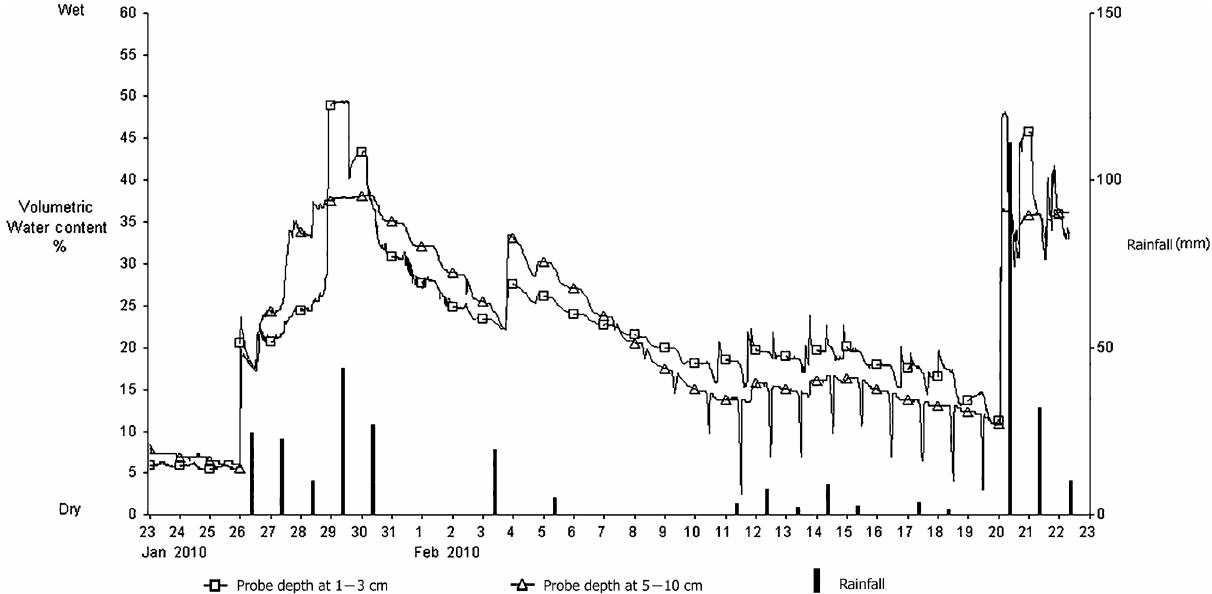
Figure 2. Example of soil moisture (volumetric water content %) patterns plotted against rainfall (mm) for 23 January to 23 February 2010 illustrating the retention of soil moisture after rain. A drying trend following significant rain was intermittently supplemented by smaller rain events, and then after 45mm of rain on the 20 February the soil profile was recharged from 15 to 50%. Note: downward spikes for 5–10cm depth after 11 February are sensor artefacts and should be ignored. Moisture was measured with MEA ThetaProbe and GP1 data logger probes